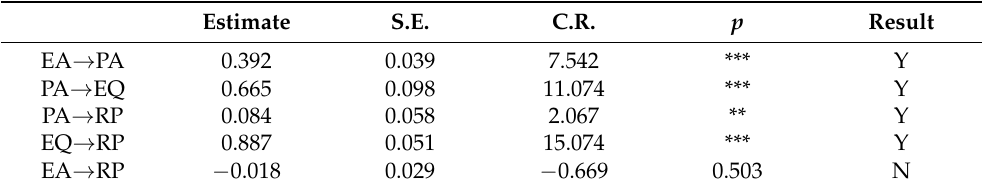
Table 10. Test of the degree of fit of the structural equation model. Estimate S.E.